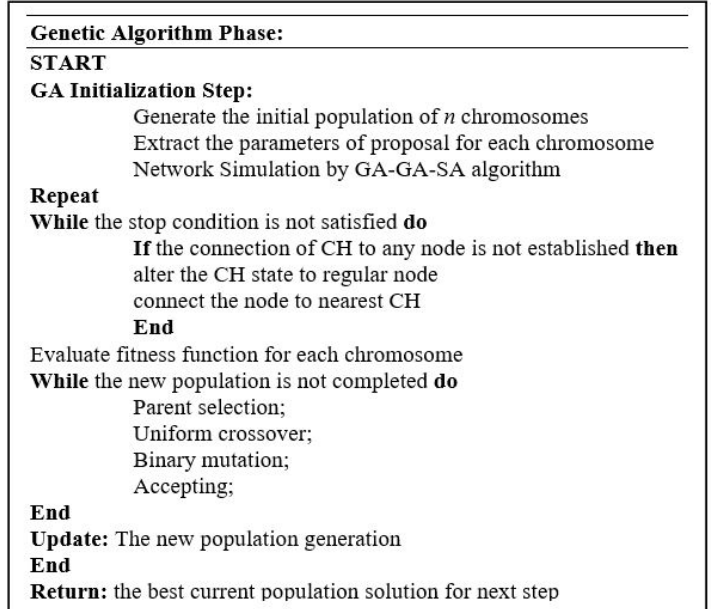
Figure 7. GA algorithm